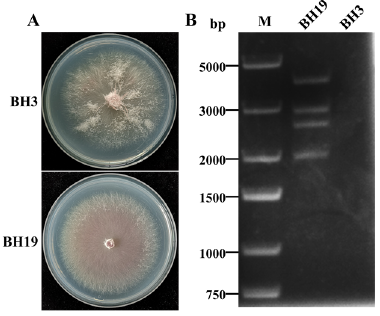
Figure 1. ( A ) Colony morphology of F. oxysporum strains BH3 and BH19. ( B ) Agarose gel electro- phoresis of the dsRNA-enriched extract obtained by cellulose column chromatography from strains BH3 and BH19.